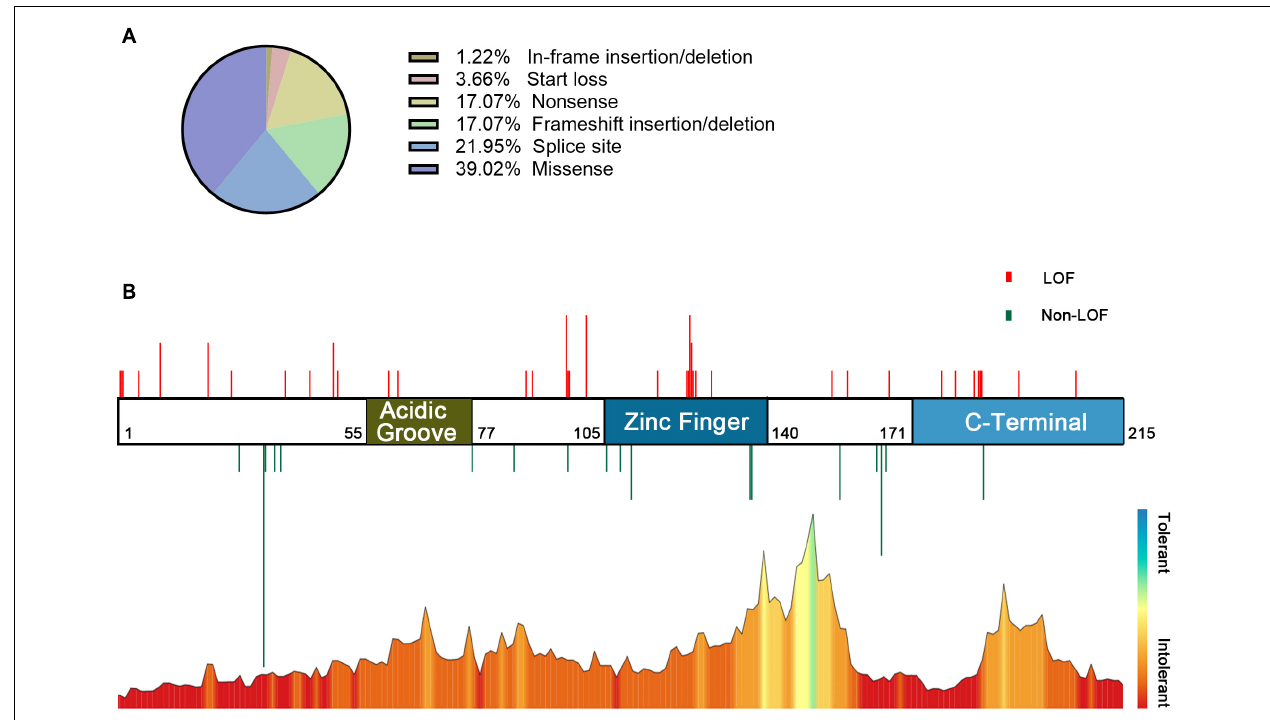
FIGURE 2 | Information on POBINDS-causing CSNK2B mutations ( n = 82). (A) Distribution of mutation types. (B) Schematic representation of the mutation distribution (top) and “MetaDome” tolerance level through whole gene (blew). Red vertical lines represent LOF mutations (including start loss, frameshift insertion/deletion, nonsense, and splicing site), and green vertical lines represent non-LOF mutations (including missense and in-frame insertion/deletion). The length of vertical lines represents the number of reported cases. The zinc finger domain is more tolerant than other regions, which is revealed by the “MetaDome” algorithm, this is also consistent with the clinical findings that missense mutation in the zinc finger domain leads to milder phenotypes. References and databases for all sources of mutation information are detailed in Supplementary Table 1